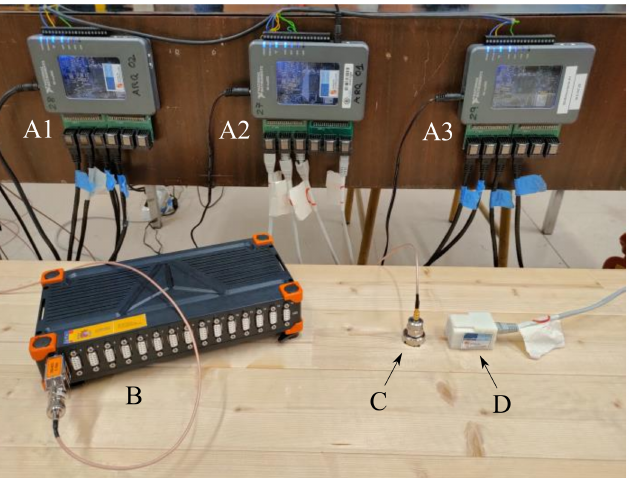
Figure 2. Three synchronized Back-end units ( A1 – A3 ), the commercial acquisition system ( B ) and two sensors: one piezoelectric accelerometer ( C ) and a digital MEMS accelerometer ( D